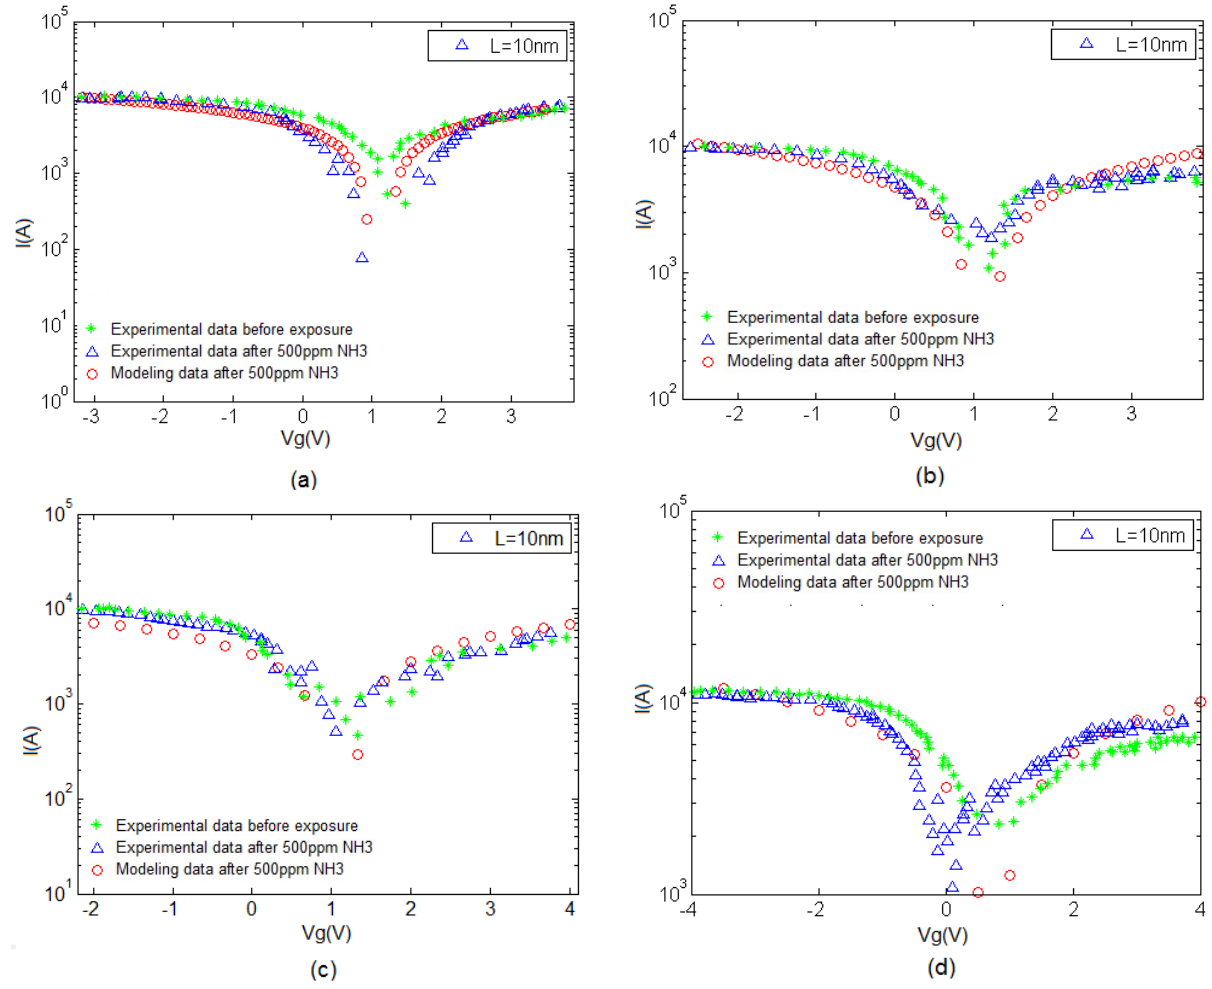
Figure 5. CNT I–V characteristics before and after exposure to NH ( b ) T = 50 °C; ( c ) T = 100 °C and ( d ) T = 150 °C showing larger conductivity values